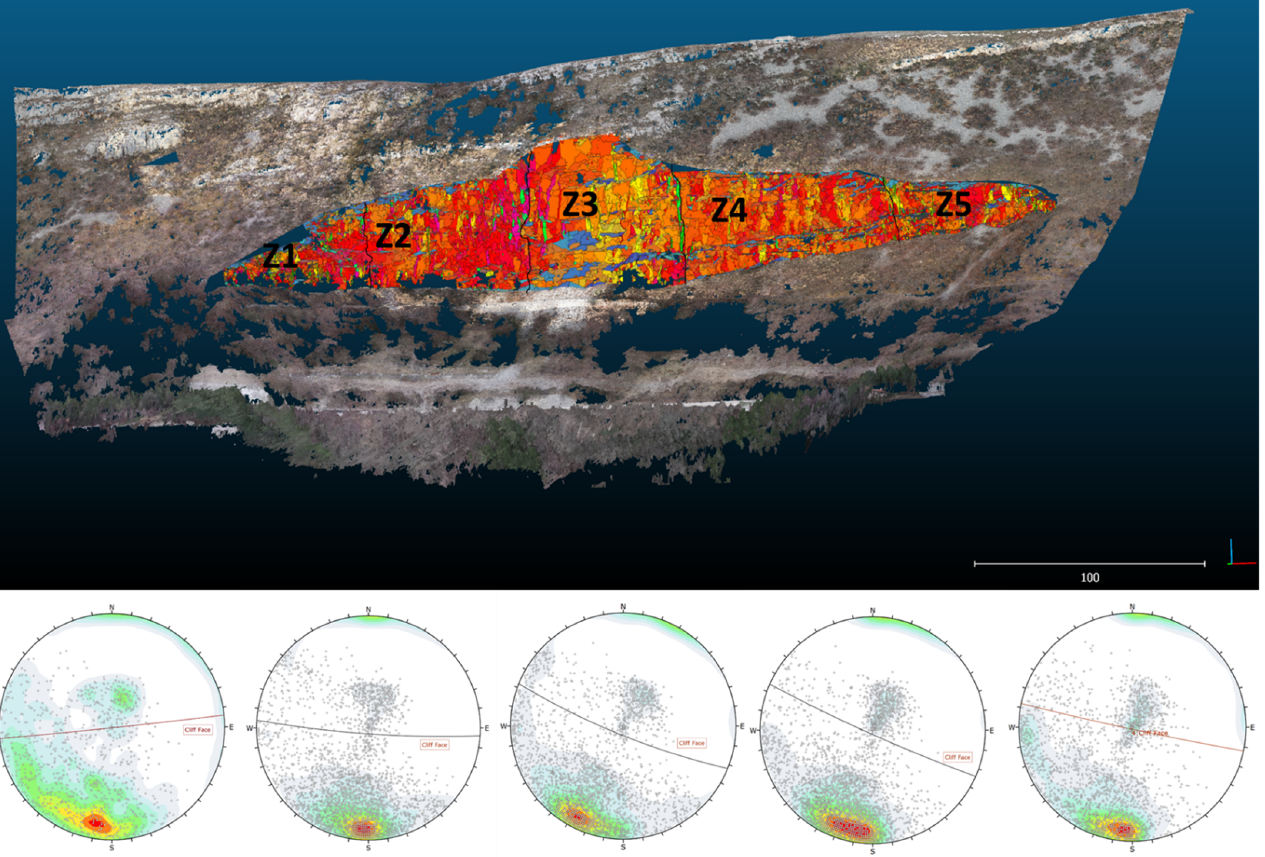
Figure 9. Three-dimensional HR Point Cloud of the Raspadalica Cliff with extracted facets using the Cloud Compare Facet plugin [43,61] (Fast Marching procedure). Orange and red to cyan facets represent Joint Set 1, parallel with the cliff face; green to yellow facets represent Joint Set 2, almost orthogonal to Joint Set 1; and blue facets represent Joint Set 3 (bedding).